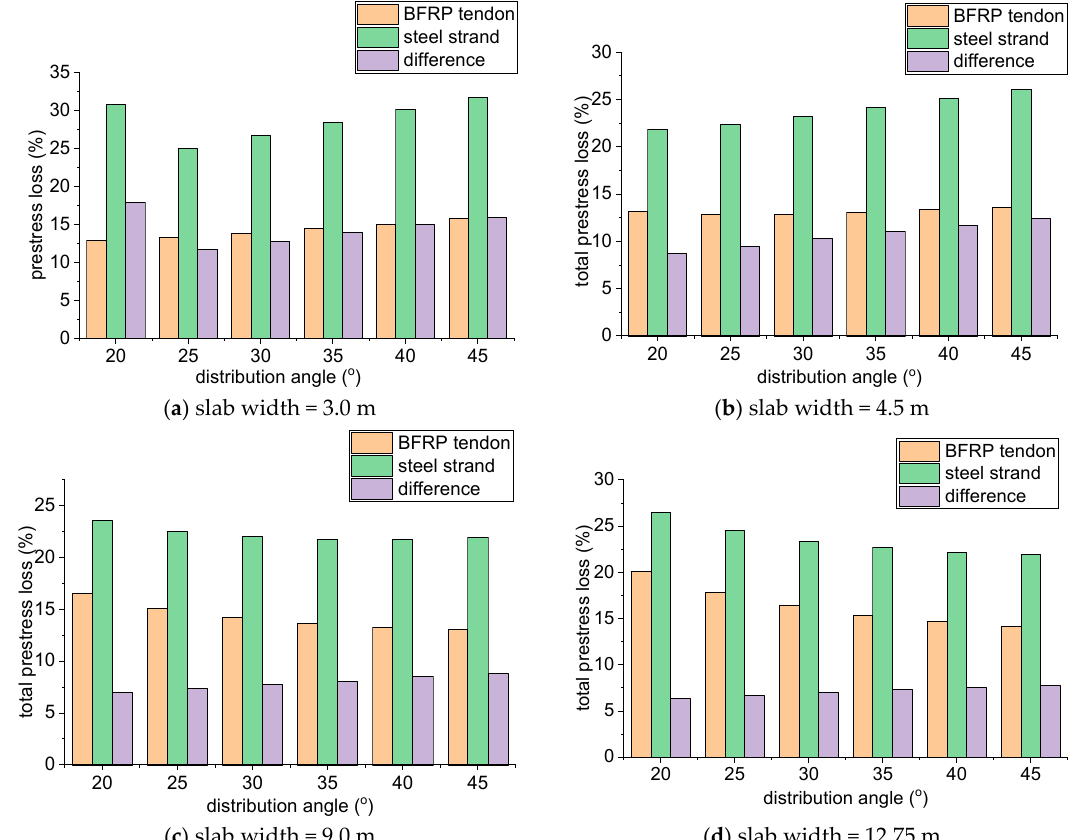
Figure 3. Difference in prestress loss between BFRP tendons and steel strands given various slab widths and distribution angles.